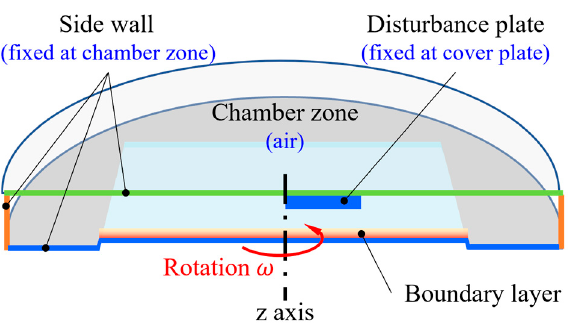
Figure 2. Schematic diagram of the spin coating chamber structure. The maximum rotation speed ω is same as the experiment parameter at 300 is same as the experiment parameter at 300 rpm.